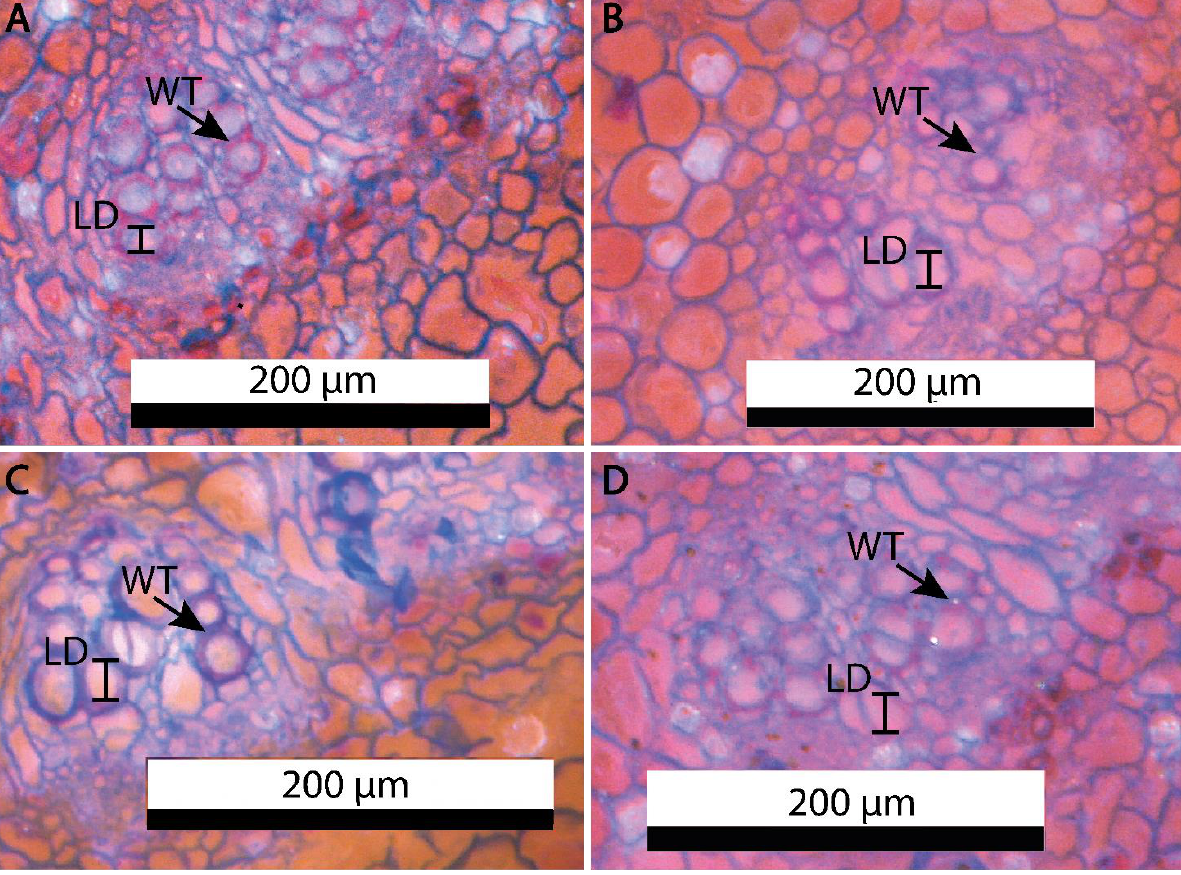
Figure 7. Histology cuts in the central vascular vein of the leaf in juveniles and adults of R. mangle . ( A ) SC + AD. ( B ) SC + JV. ( C ) SB + AD. ( D ) SB + JV. ( E ) OP + AD. ( F ) OP + JV. DL = Diameter of the lumen of the xylem vessels; WT = Thickness of the wall of the xylem vessels. 4. Discussion 4.1 Functional Traits and Response to the Salinity Ranges Salinity results show a gradient in the eastern part of San Andrés island, beginning low towards the southern part of the island (Smith Channel forest) with intermediate salinities in the middle part of the island (Sound Bay forest) and ending in high salinities towards the northern part (Old Point forest). The marked and differential ranges in each forest indicated that the conditions of salinity stress were contrasting. This explained the